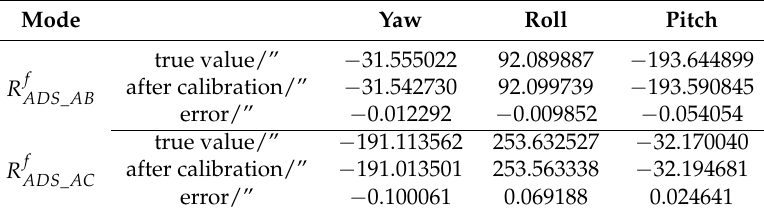
Table 5. The calibration accuracy of the relative fiducial